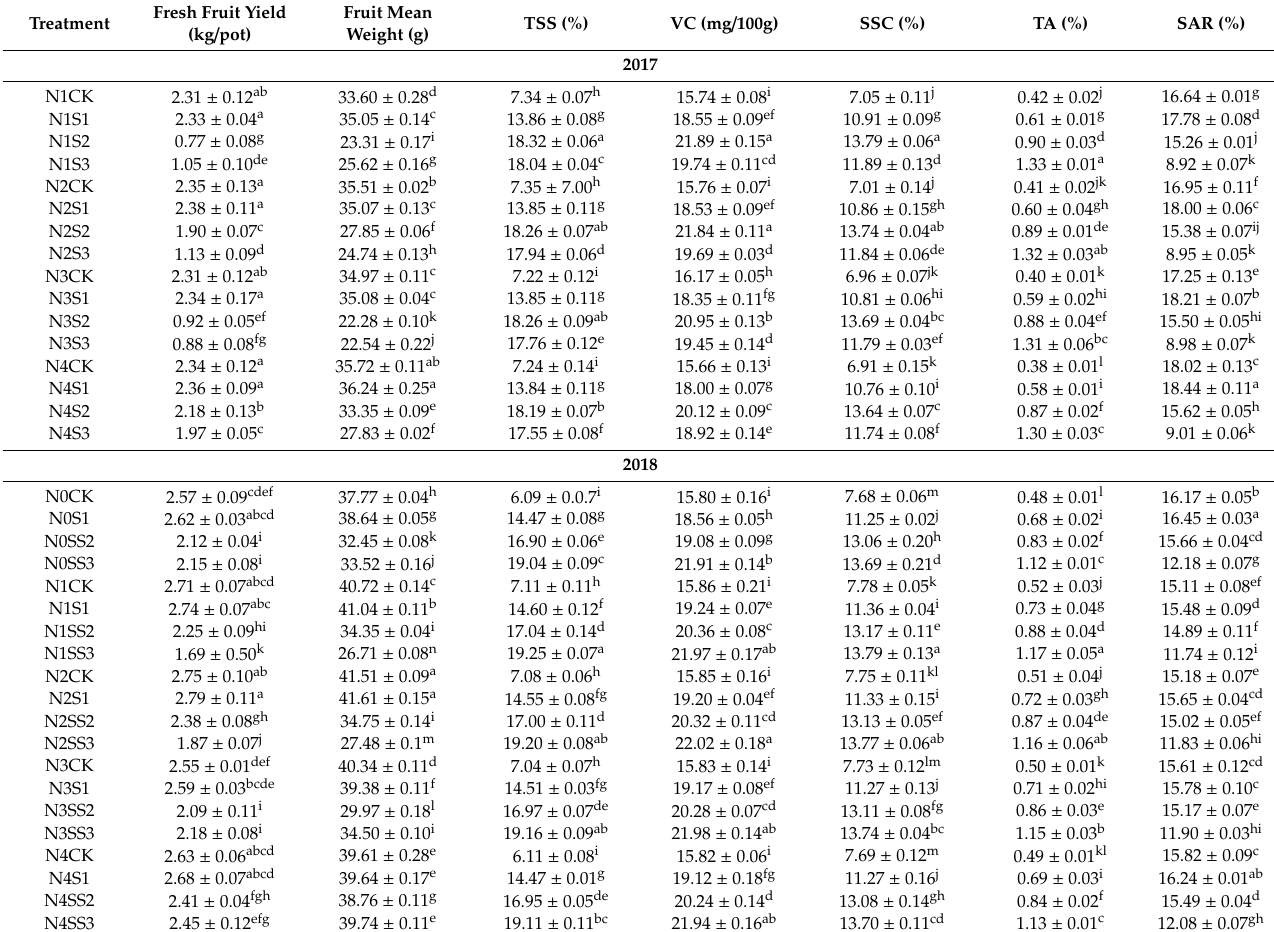
Table 3. Yield and quality of tomato in di ff erent treatments, showing mean ± standard deviation, with di ff erent letters indicating significant di ff erences between treatments ( p < 0.05). TSS stands for total soluble solids, VC for vitamin C content, SSC for total soluble sugar content, TA for titratable acid, and SAR for the ratio of sugar to